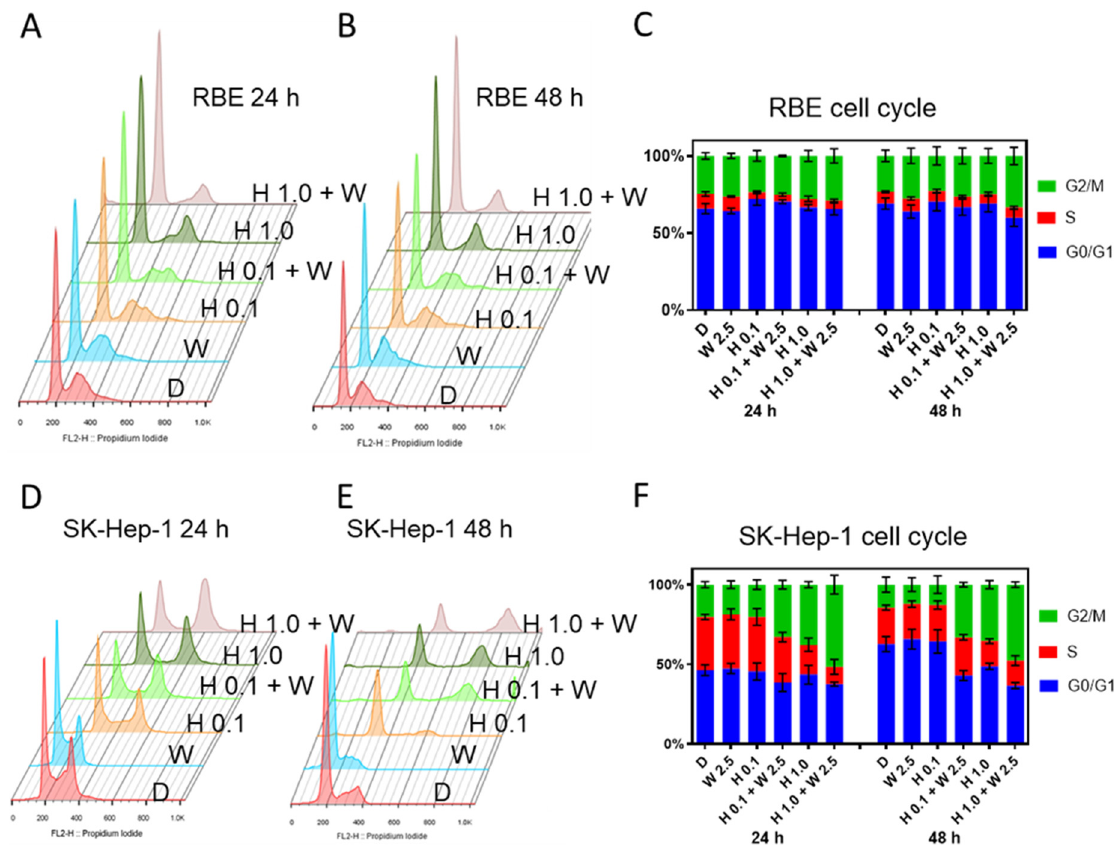
Figure 5. GSK2830371 induced G2/M phase arrest compared with HDM201 alone. RBE ( A – C ) and SK-Hep-1 ( D – F ) cells were treated with 0.1 or 1 µM HDM201 alone or in combination with 2.5 µM WIP1i for 24 and 48 h. Panels A , B , D , and E show representative histogram profiles of the cell cycle. Panels C and F summarize the cell cycle distributions for GO/G1, S, and G2/M phase from at least 3 independent replicates. D, DMSO; W, WIP1i; H, HDM201. All data represent the mean ± SEM from three independent experiments performed in duplicate.